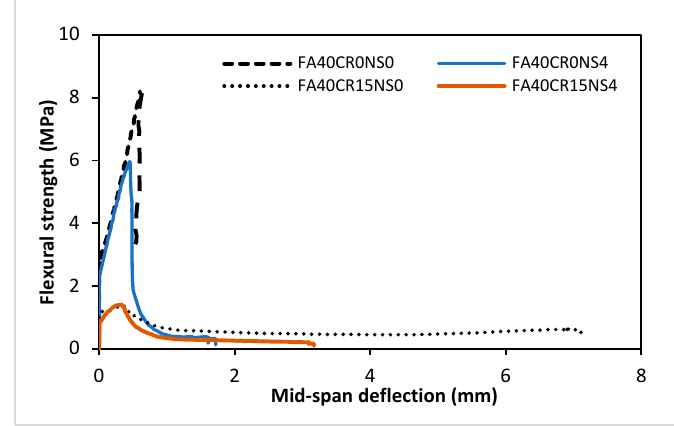
Figure 9. Stress-deflection curve for flexural test.